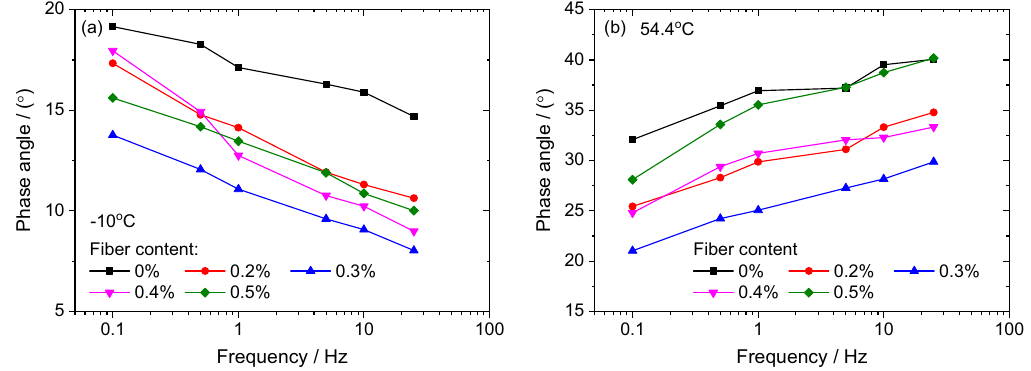
Figure 6: Phase angles of AC mixtures with various basalt fi bers from frequency sweep measurements at ( a ) − 10°C and ( b ) 54.4°C.